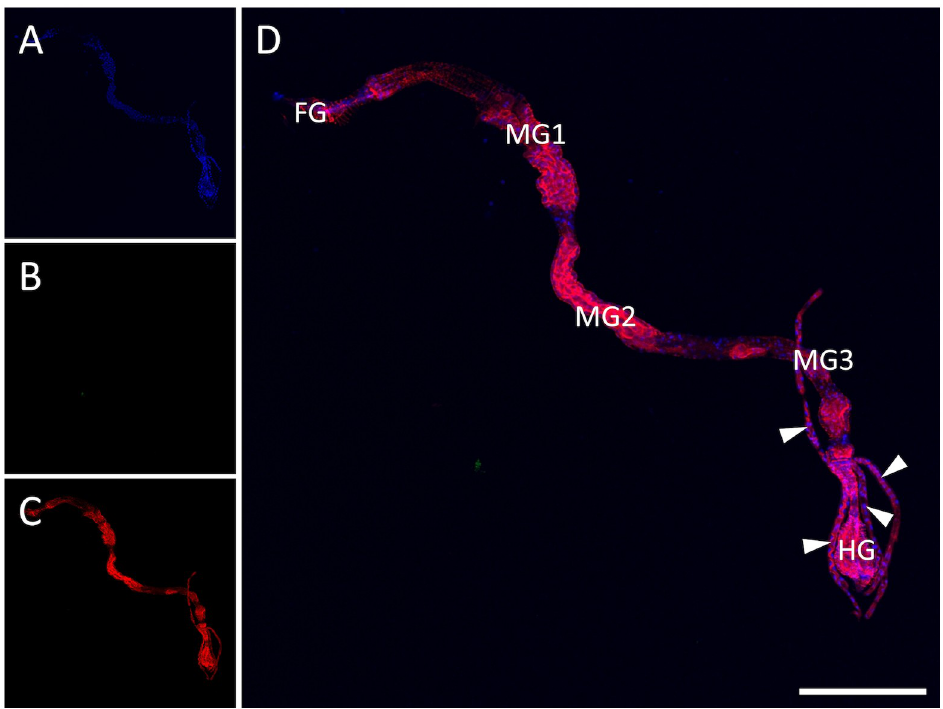
Fig 1. Indirect immunofluorescence detection of watermelon silver mottle virus (WSMoV) in non-viruliferous Thrips palmi . (A) Nuclei of cells stained with the DNA selective dye DAPI. (B) No WSMoV antigen detected. (C) Actin stained with phalloidin conjugated with Alexa Fluor 633. (D) Merged image, indicating that no WSMoV antigen was detected in the alimentary tract. WSMoV antigen was detected using rabbit antiserum against WSMoV nucleocapsid protein and a secondary antibody conjugated with Alexa Fluor 555. Actin was stained to delineate cell boundaries and tissue types. The confocal image depicting alimentary tract of a thrips is a representative image from 12 non-viruliferous thrips examined in this study. FG: foregut, MG: midgut, HG: hindgut. Arrowheads point to Malpighian tubules. Scale bar = 250 μ